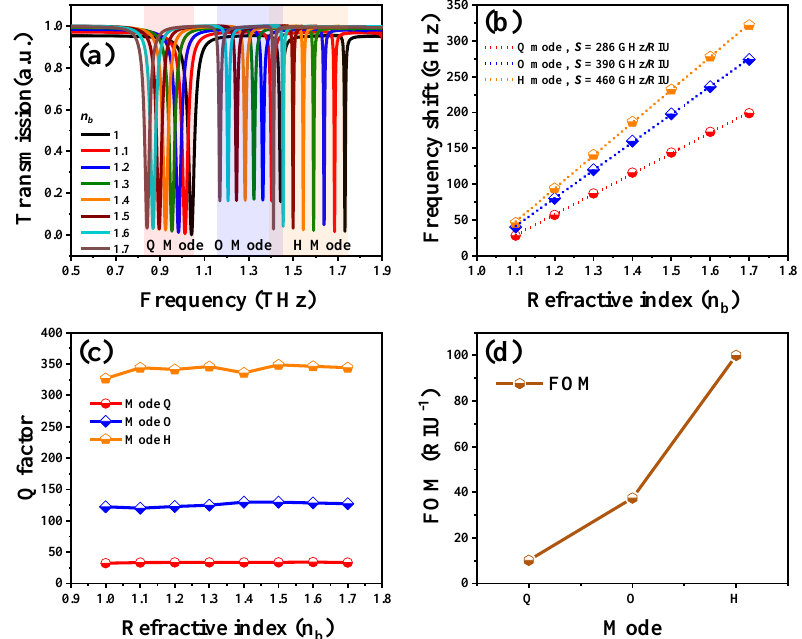
Figure 4. ( a ) Transmission spectra of SSM with di ff erent n b values. ( b ) Frequency shifts and ( c ) Q-factors plotted against the n b values. ( d ) The average figure of merit (FOM) values of Q, O and H